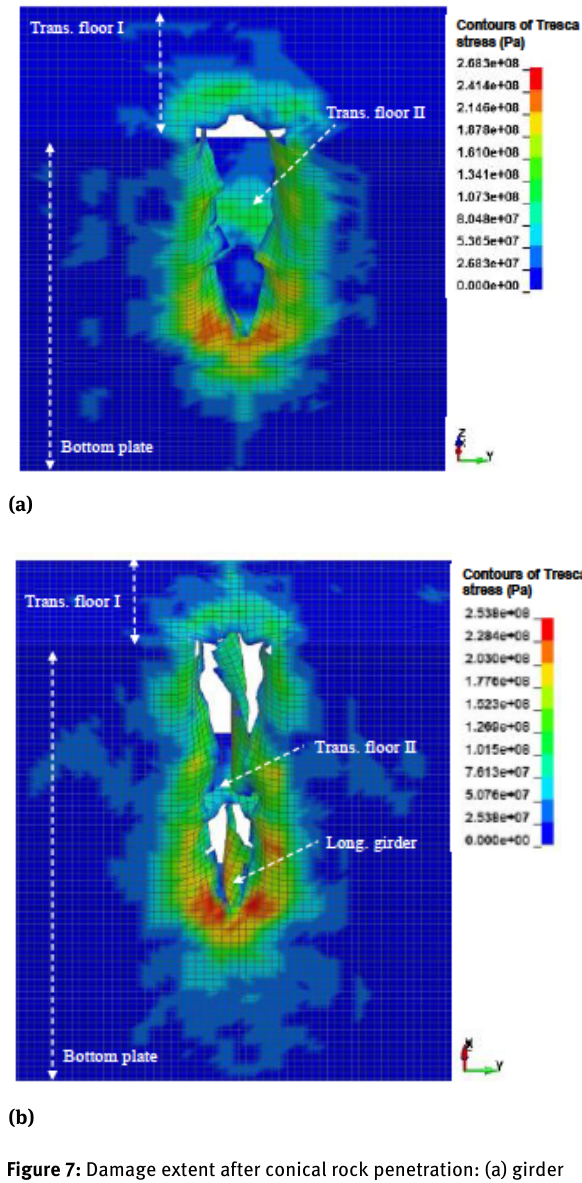
Figure 7: Damage extent after conical rock penetration: (a) girder space and (b) longitudinal girder.